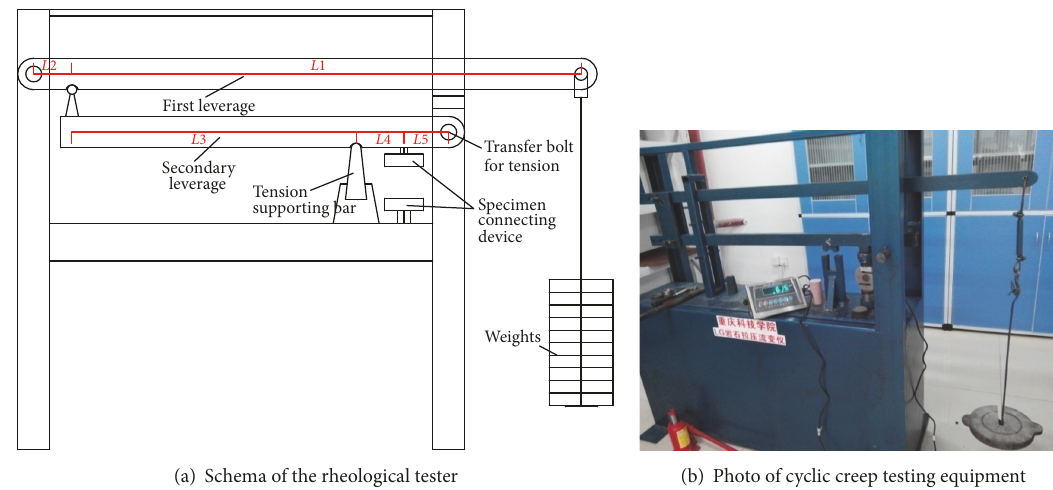
Figure 3: A lever-type tensile and a compression rheological tester [16].